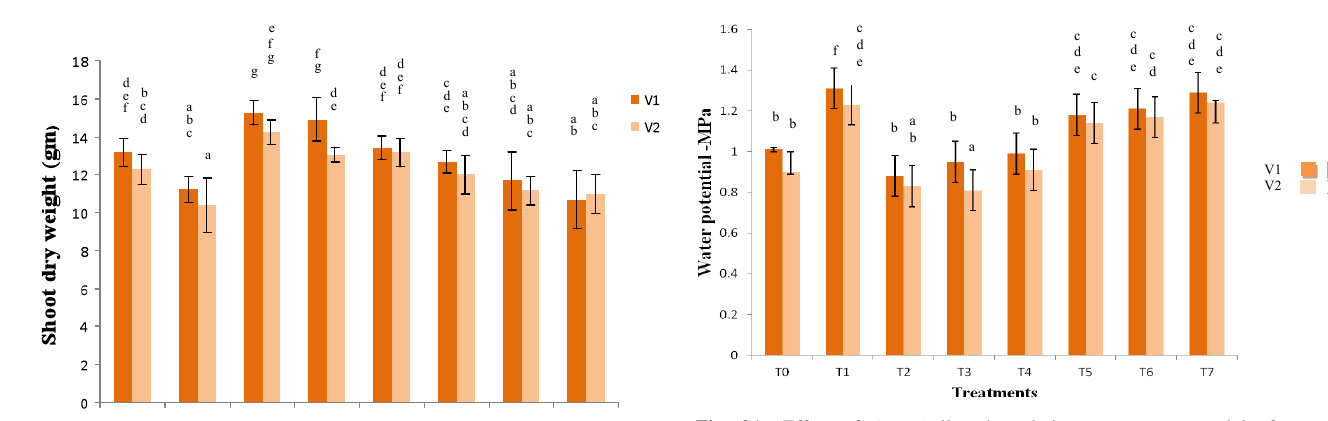
Fig. 2A: Effect of Azospirillum inoculation on water potential of two canola varieties (v1 and v2) grown under drought stress. Where, To = Un-inoculated and well watered, T = Un-inoculated and drought exposed, T2 = Seed inoculated and well watered, T3 = Rhizosphere inoculated and well watered, T4 = Seed inoculated with heat killed inoculums and well watered, T5 = Seed inoculated and drought exposed, T6 = Rhizosphere inoculated and drought ex- posed, T7 = Seed inoculated with heat killed inoculums and drought exposed. And V1 = Rainbow, V2 = Con